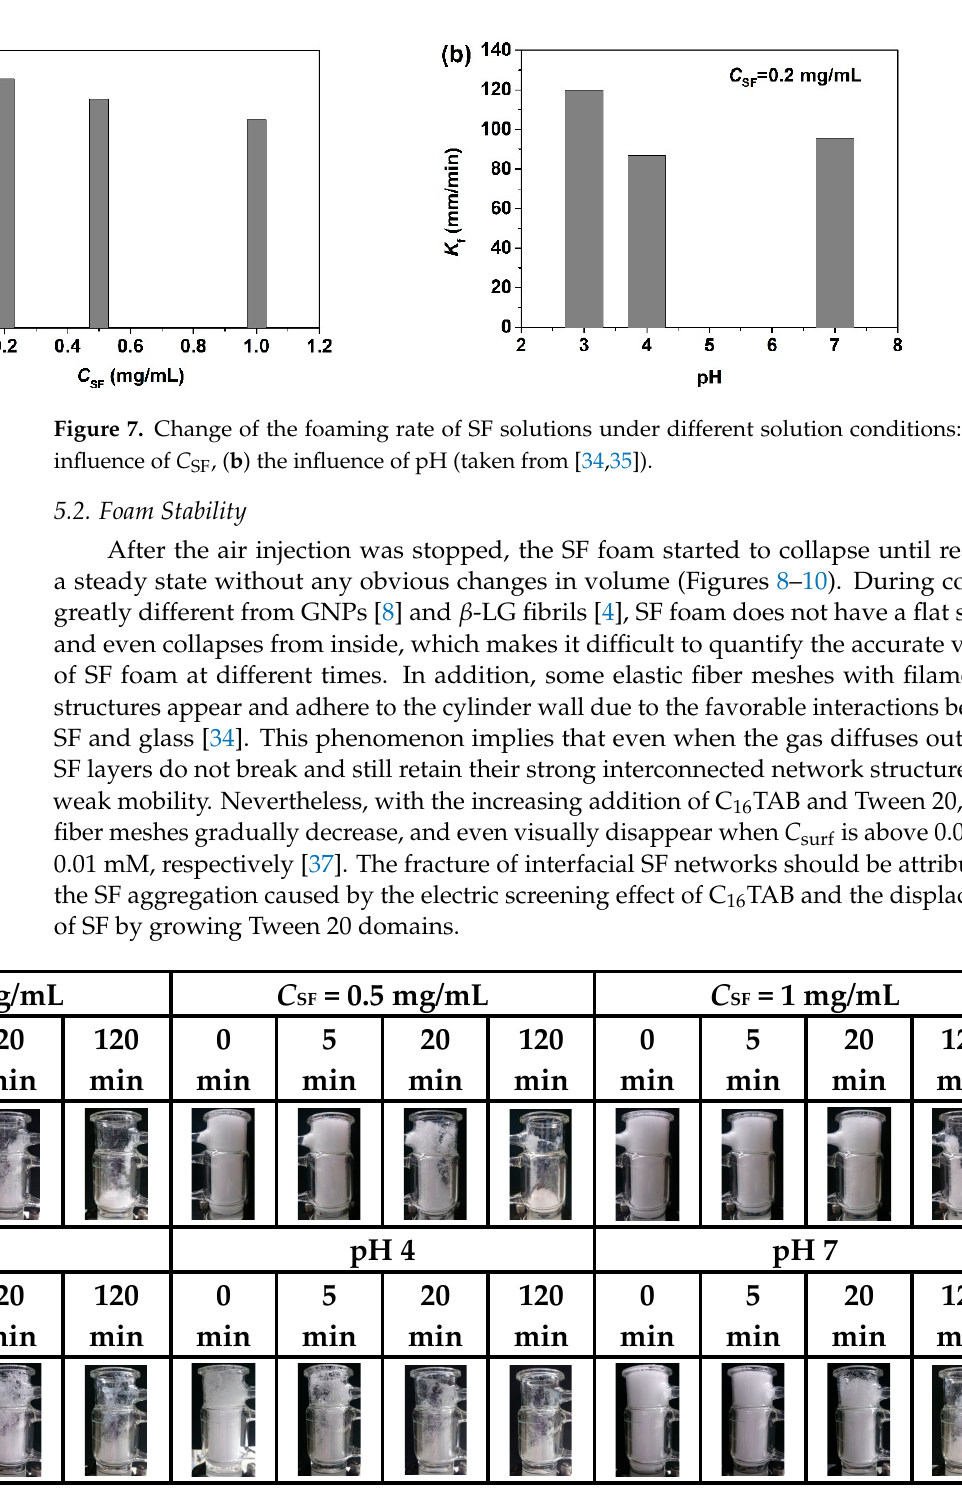
10 of 16 Figure 6. Change of the degree of structure fracture ( η f ) with strain ( γ ) for equilibrium adsorbed SF layers formed at the air/water interface under different solution conditions: ( a ) influences of C SF ; ( b ) influences of salts; ( c ) influences of surfactants. The inset in ( a ) is the double ‐ logarithmic plot of the interfacial shear storage modulus ( G’ ) versus shear strain ( γ ) (taken from [34,36,37]). 5. The Foaming Properties of Aqueous Silk Fibroin Solutions 5.1. Foamability SF foams can be easily prepared by the bubbling method through injection of air into different SF solutions through a porous glass frit. The minimum protein concentration required to generate foam with aqueous SF solutions is 0.1 mg/mL [34], 100 times lower than that for rigid globular ovalbumin and glycinin (above 10 mg/mL) [10]. This indicates the superior foamability of SF with its high flexibility and fast molecular adsorption. Foams are thermodynamically unstable systems. It is clear that SF can be a stabilizer for foams although the final “stable” volume fraction is not very large. The surface activity promotes SF to generate the foam, and the adsorbed SF layers with a high G’ help maintain the foam structure through mechanical protection against bubble coalescence and rup ‐ ture. The foamability of SF was quantified in terms of the foaming rate ( K f ) by dividing the foam height by the time at a constant air flow (Figure 7). K f is around 140 mm/min when C SF < 0.2 mg/mL, and then decreases to approximately 120 mm/min for C SF = 1 mg/mL [34]. Moreover, K f is lower at pH 4 than at pH 3 and pH 7 [35]. Just as mentioned above, the SF molecules need more time to reach equilibrium when forming surface layers